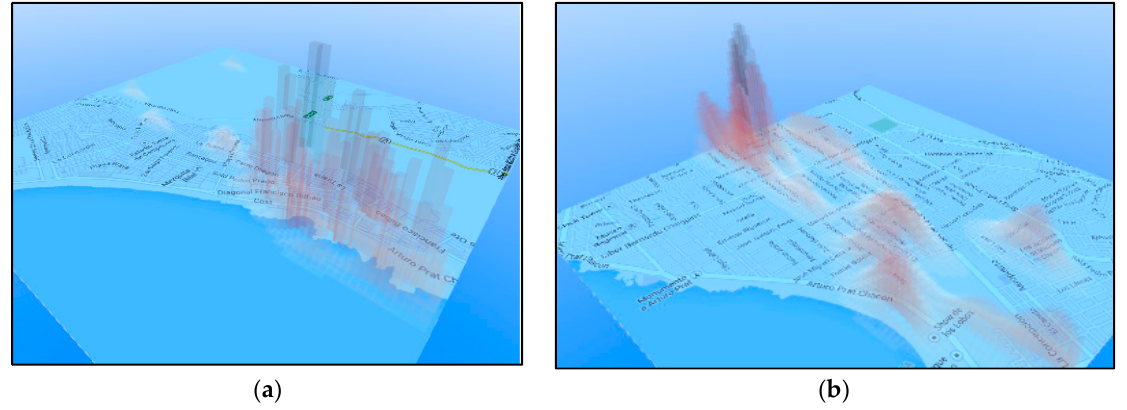
Figure 7. ( a ) Scenario 3: Beach area. ( b ) Scenario 3: Commercial areas.